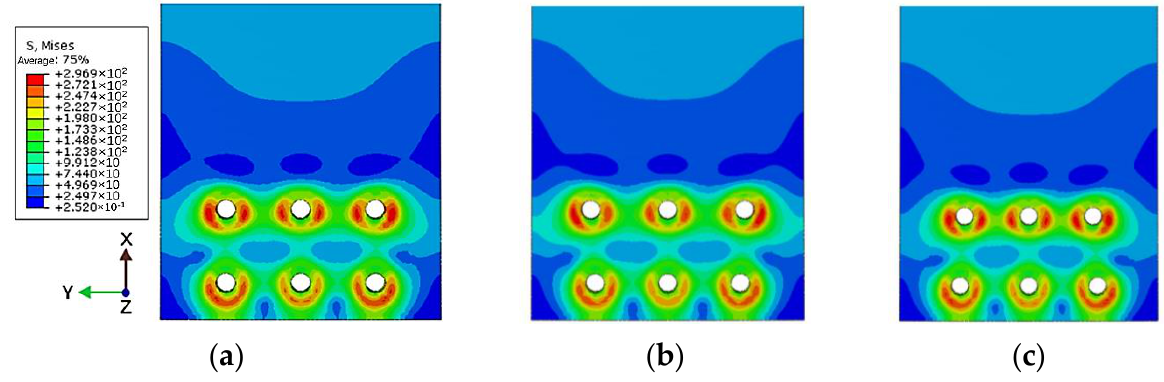
Materials 2021 , 14 , x FOR PEER REVIEW